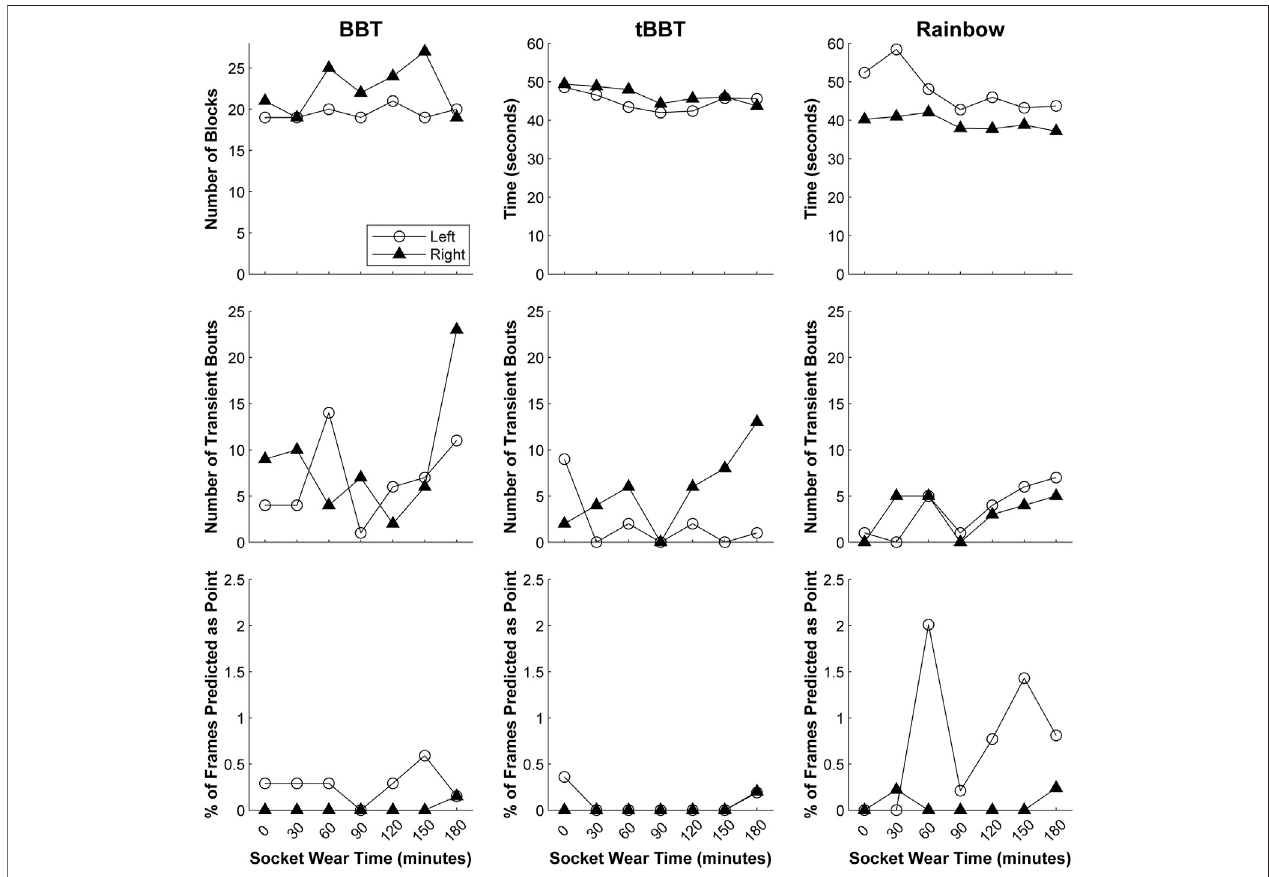
FIGURE 10 | Functional outcome measures achieved during 3-h testing. Testing with both arms was completed using a classi fi er trained with a continuous dynamic strategy under the load B condition (BBT = Box and Blocks Test; tBBT = Targeted Box and Blocks Test).